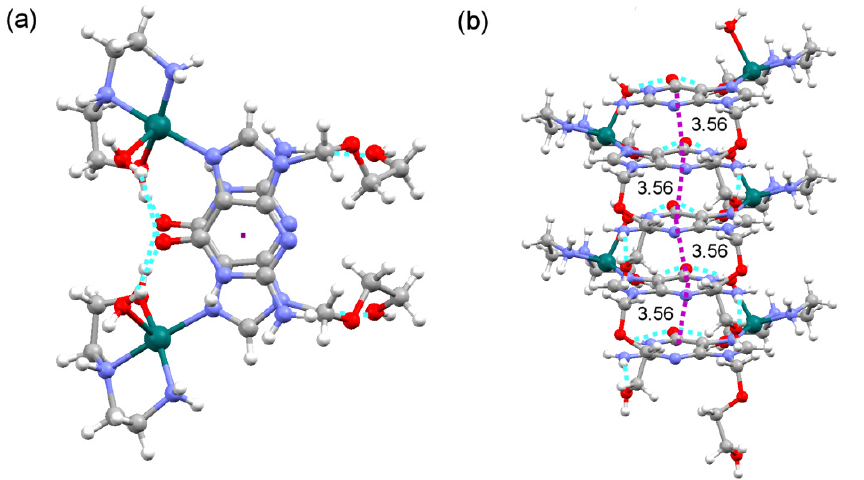
Figure 4. View of the π -stacked complex cations in compound 2 ( a ) in the c axis and ( b ) along the c axis. H-bonds and π , π -stacking interactions are depicted in cyan dotted lines and purple dashed lines, respectively. Nitrate anions are omitted for clarity. Distances given in Å. Atoms colour code: carbon—grey; hydrogen—white; nitrogen—blue; oxygen—red; copper—dark green.